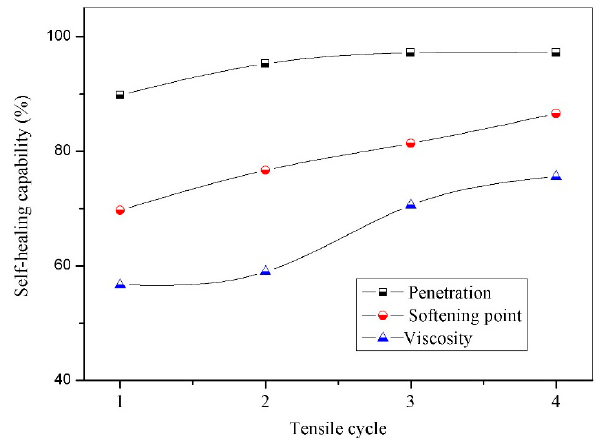
Figure 9. Self-healing capability of microcapsules/bitumen samples (microcapsules: 3.0 wt. %, 20 μ m) calculated by properties values (penetration, softening point and viscosity) during a reparative fracture-healing process (four recycles) under 0 °C, each cycle healing time of 24 h.